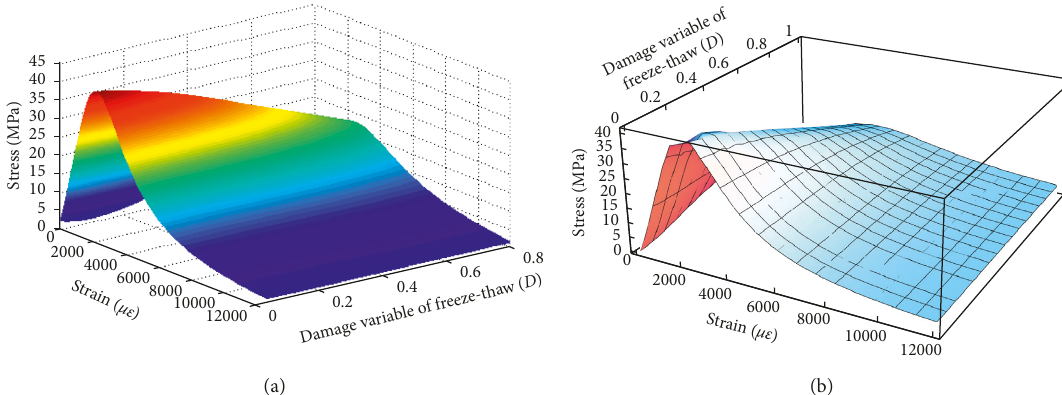
Figure 5: Full stress-strain surface with freeze-thaw damage variable. (a) Drawn by fitting the data. (b) Drawn using equation